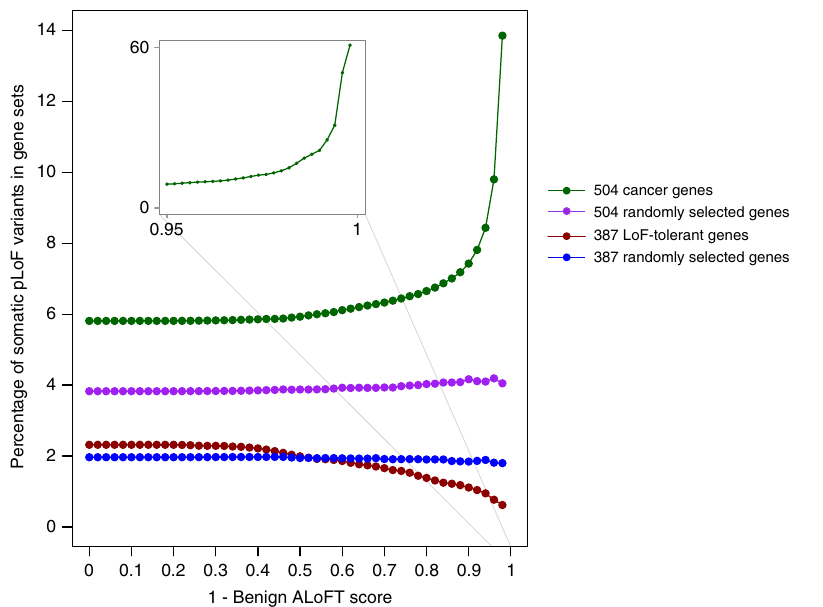
Fig. 4 ALoFT classi fi cation of somatic premature stop variants. The fraction of mutations occurring in various gene categories ( Y axis) as a function of predicted diseasing-causing score for cancer somatic premature stop variants ( X axis). Disease-causing score is calculated as (1 — predicted benign ALoFT score). We calculated the fraction of somatic premature stop mutations in 504 known cancer driver genes and 504 randomly selected genes. To ensure that the cancer driver genes and the randomly selected genes have similar length distributions, the 504 random genes were selected from genes with matched length. Similarly, we compared the fraction of somatic premature stop mutations in 397 LoF-tolerant genes and 397 randomly selected genes with similar length distribution. LoF-tolerant genes are genes that have at least one homozygous LoF variant in at least one individual in the 1KG